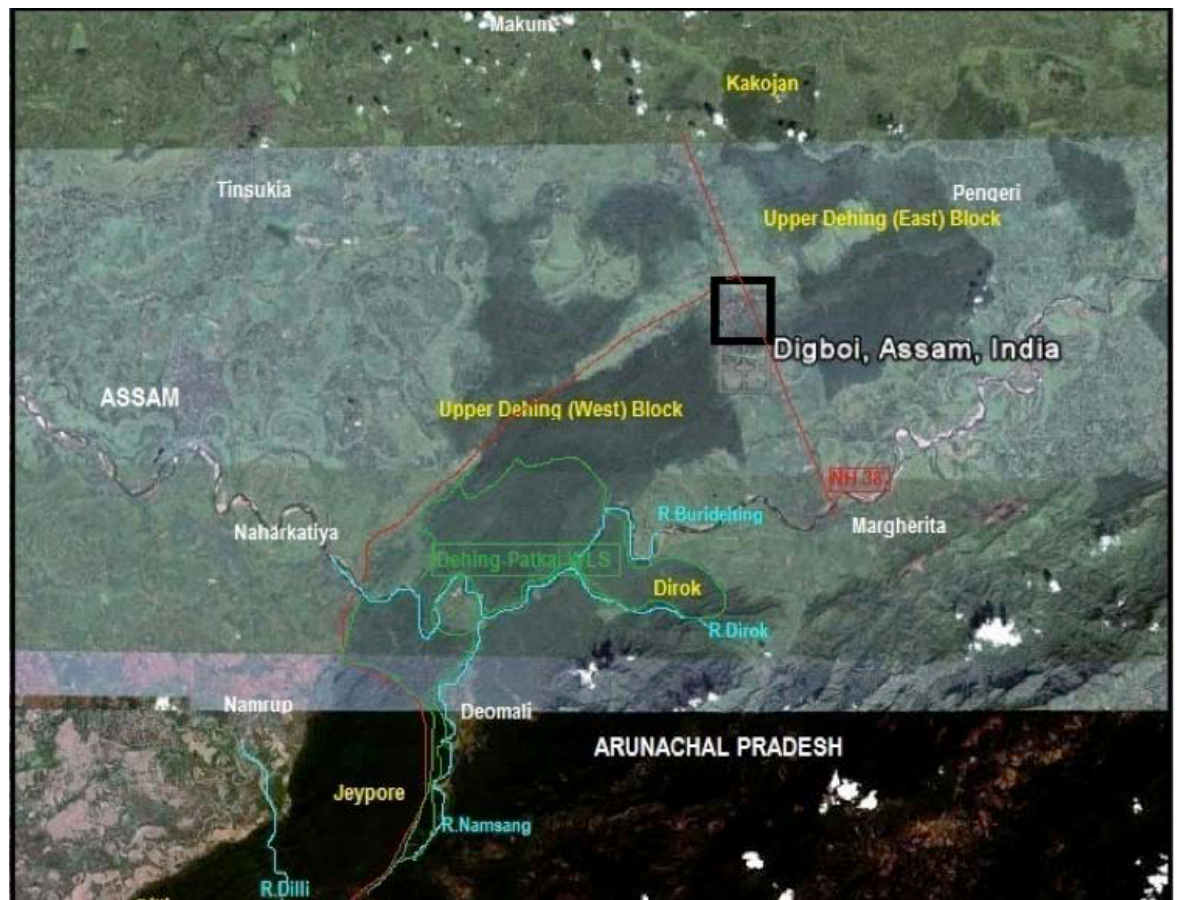
Image 1 . Google map of Jeypore-Dehing landscape, Upper Assam, Coutrsey: Kashmira Kakati/WII 2002